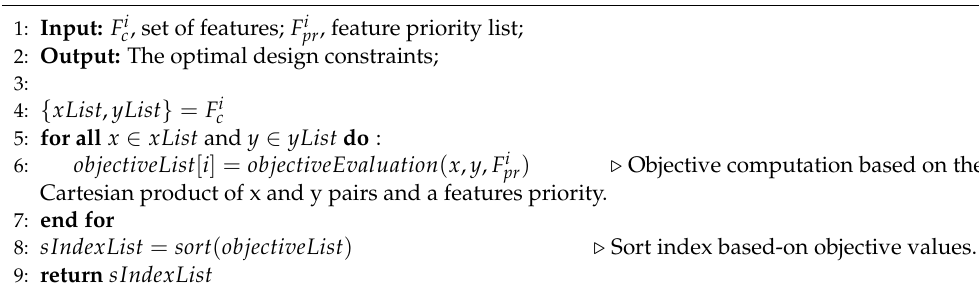
Algorithm 2 Iterative greedy search